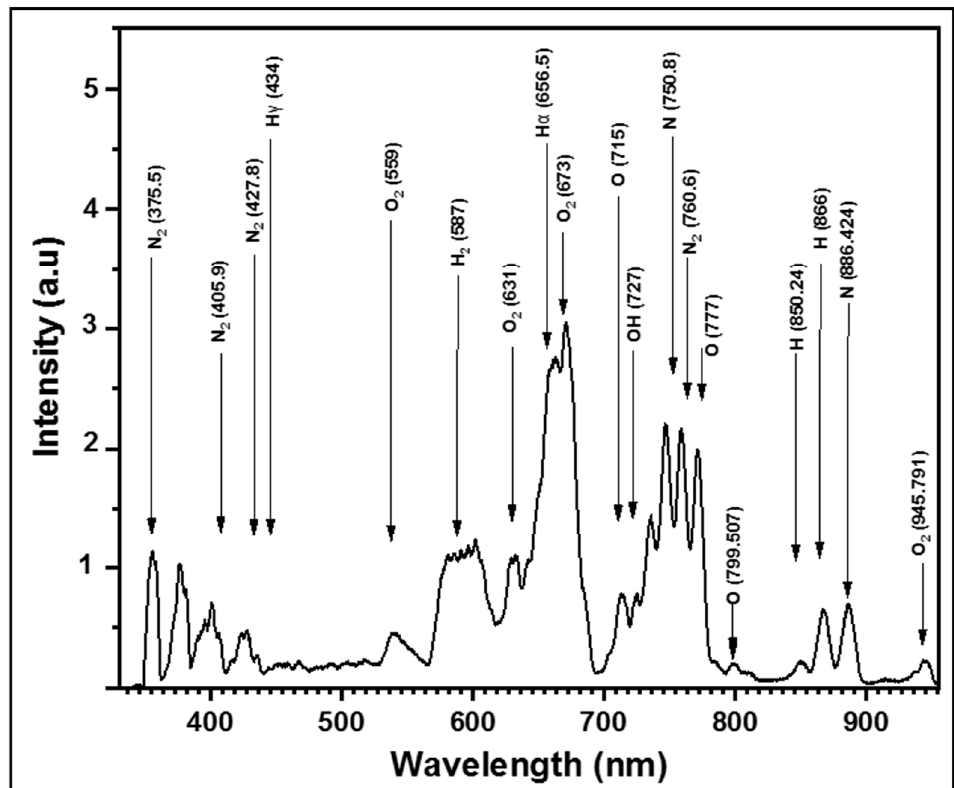
Figure 10. Optical spectrum emitted from low-pressure water plasma at a power of 10 W.